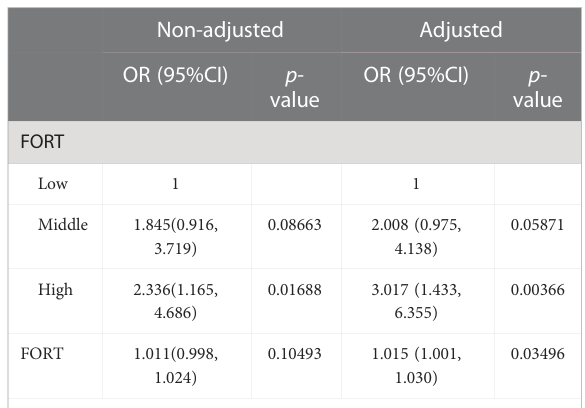
TABLE 3 Follicular output rate and cumulative clinical pregnancy rate.